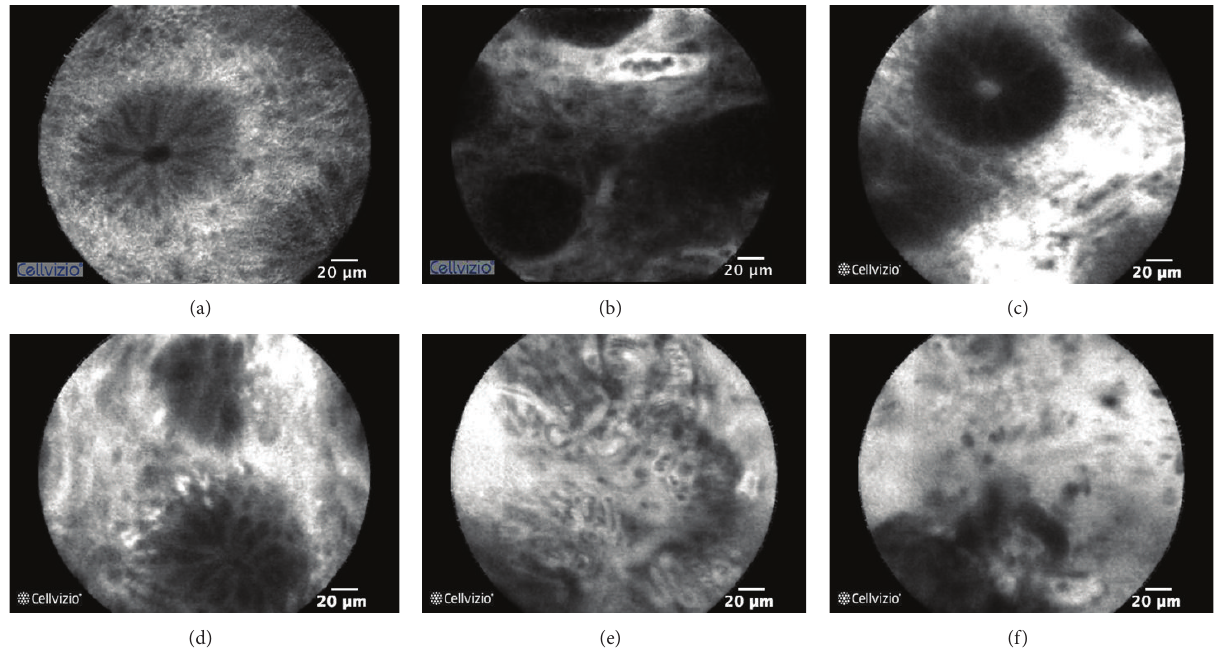
Figure 3: Probe-based confocal laser endomicroscopy (pCLE) patterns observed in GI-GVHD patients following intravenous injection of fluorescein. (a) Normal sigmoid, (b) abnormal microvessel network with dilation of a microvessel surrounding a colonic crypt (mild GVHD), (c) mild increase in fluorescein intensity in the lamina propria (mild GVHD), (d) distorted crypts (moderate GVHD), and ((e), (f)) major architectural changes showing proliferation and dilation of microvessels in the lamina propria, major fluorescein extravasation, and complete destruction of the colonic crypt architecture (severe